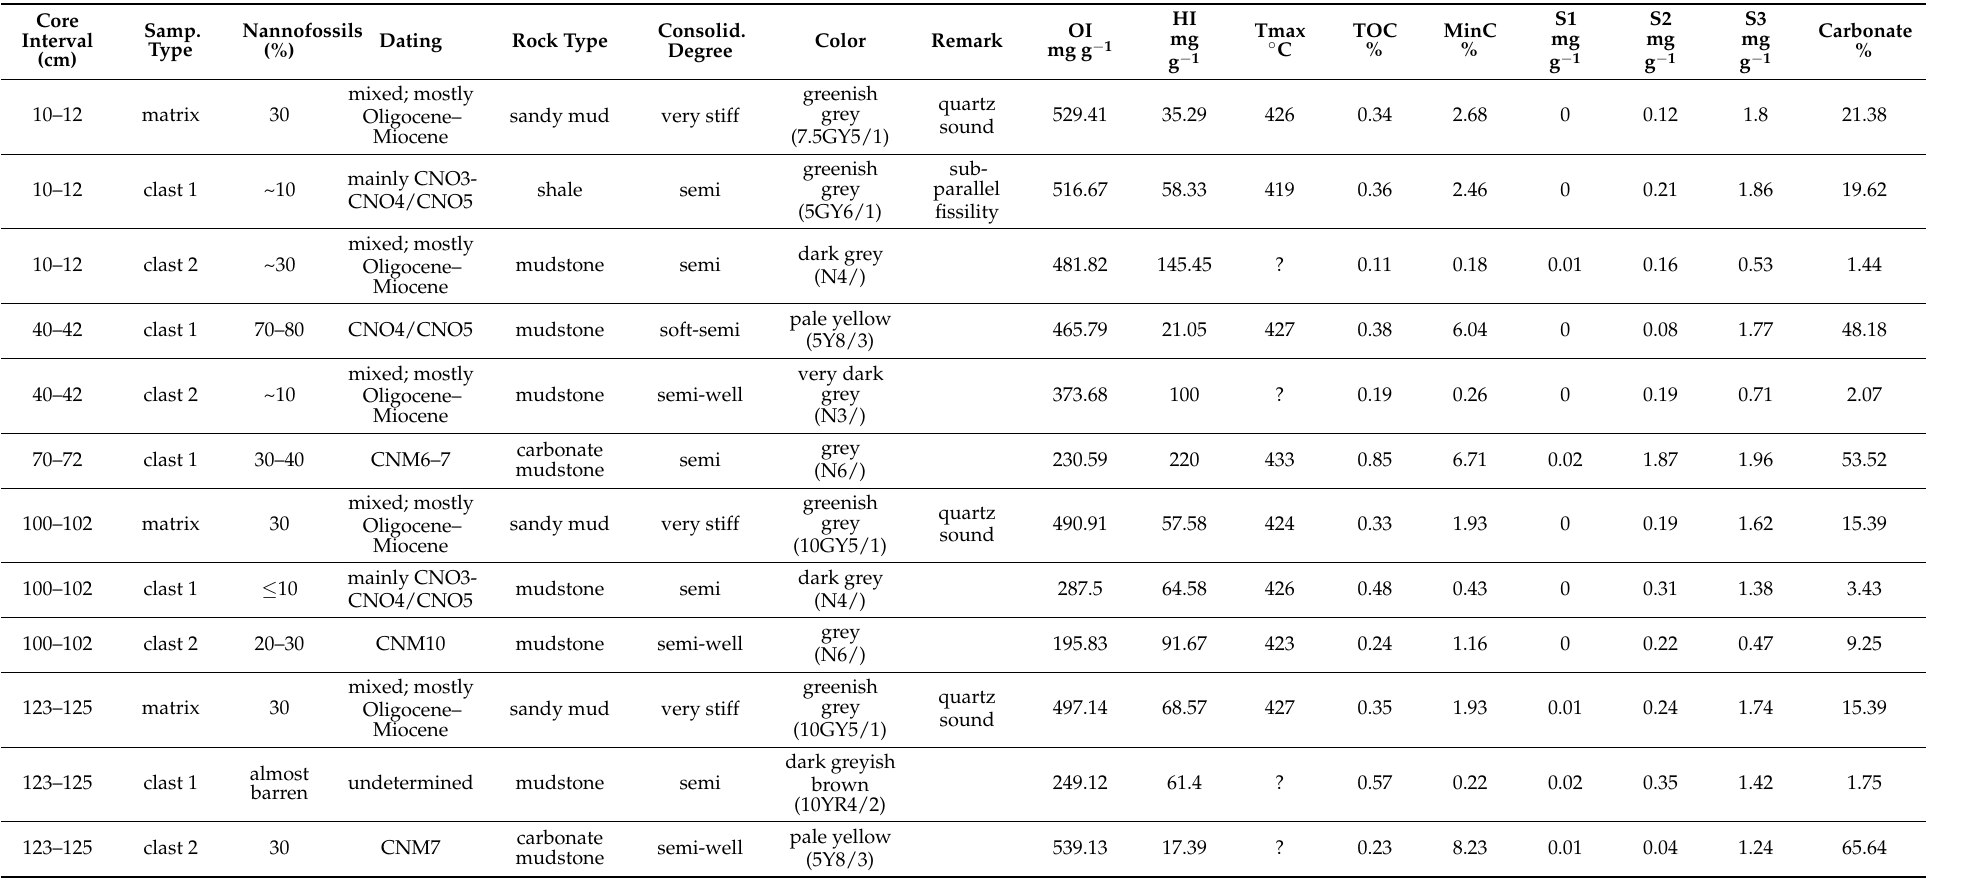
Table A3. Moscow MV (LEV5GC